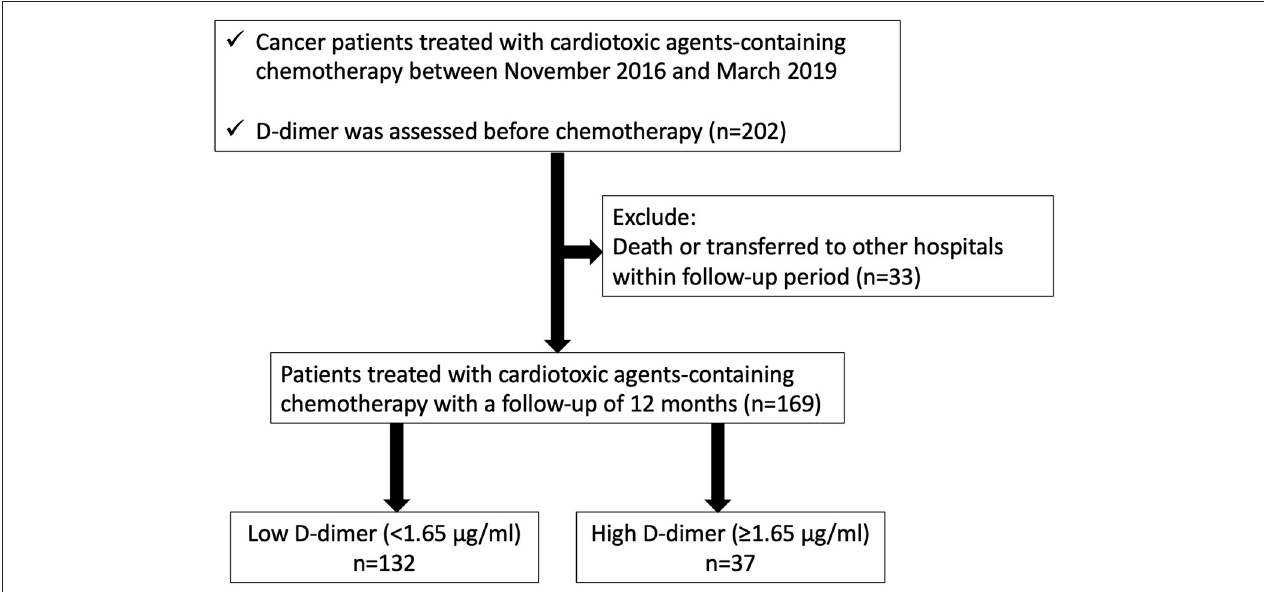
FIGURE 1 | Patient cohort selection.